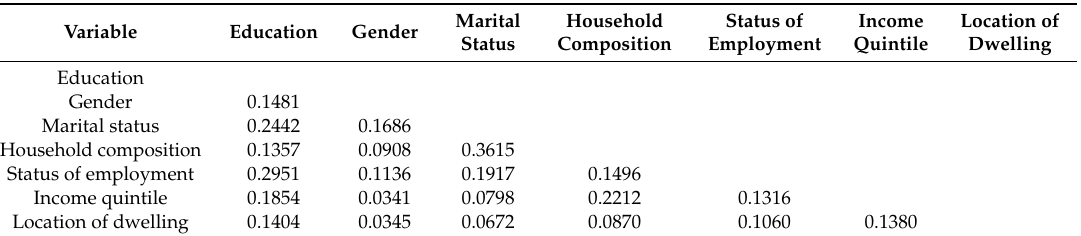
Table A2. Values of the Cramer’s V measure for 2016–2017 data.